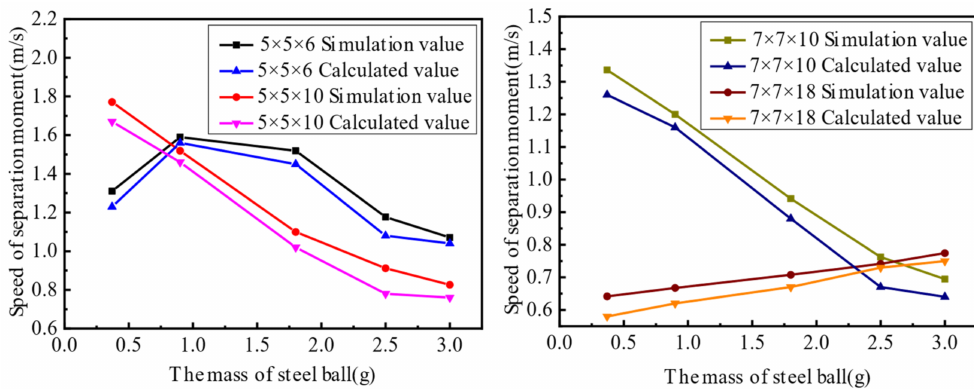
Figure 9. Comparison of simulated and experimental values in the third set of